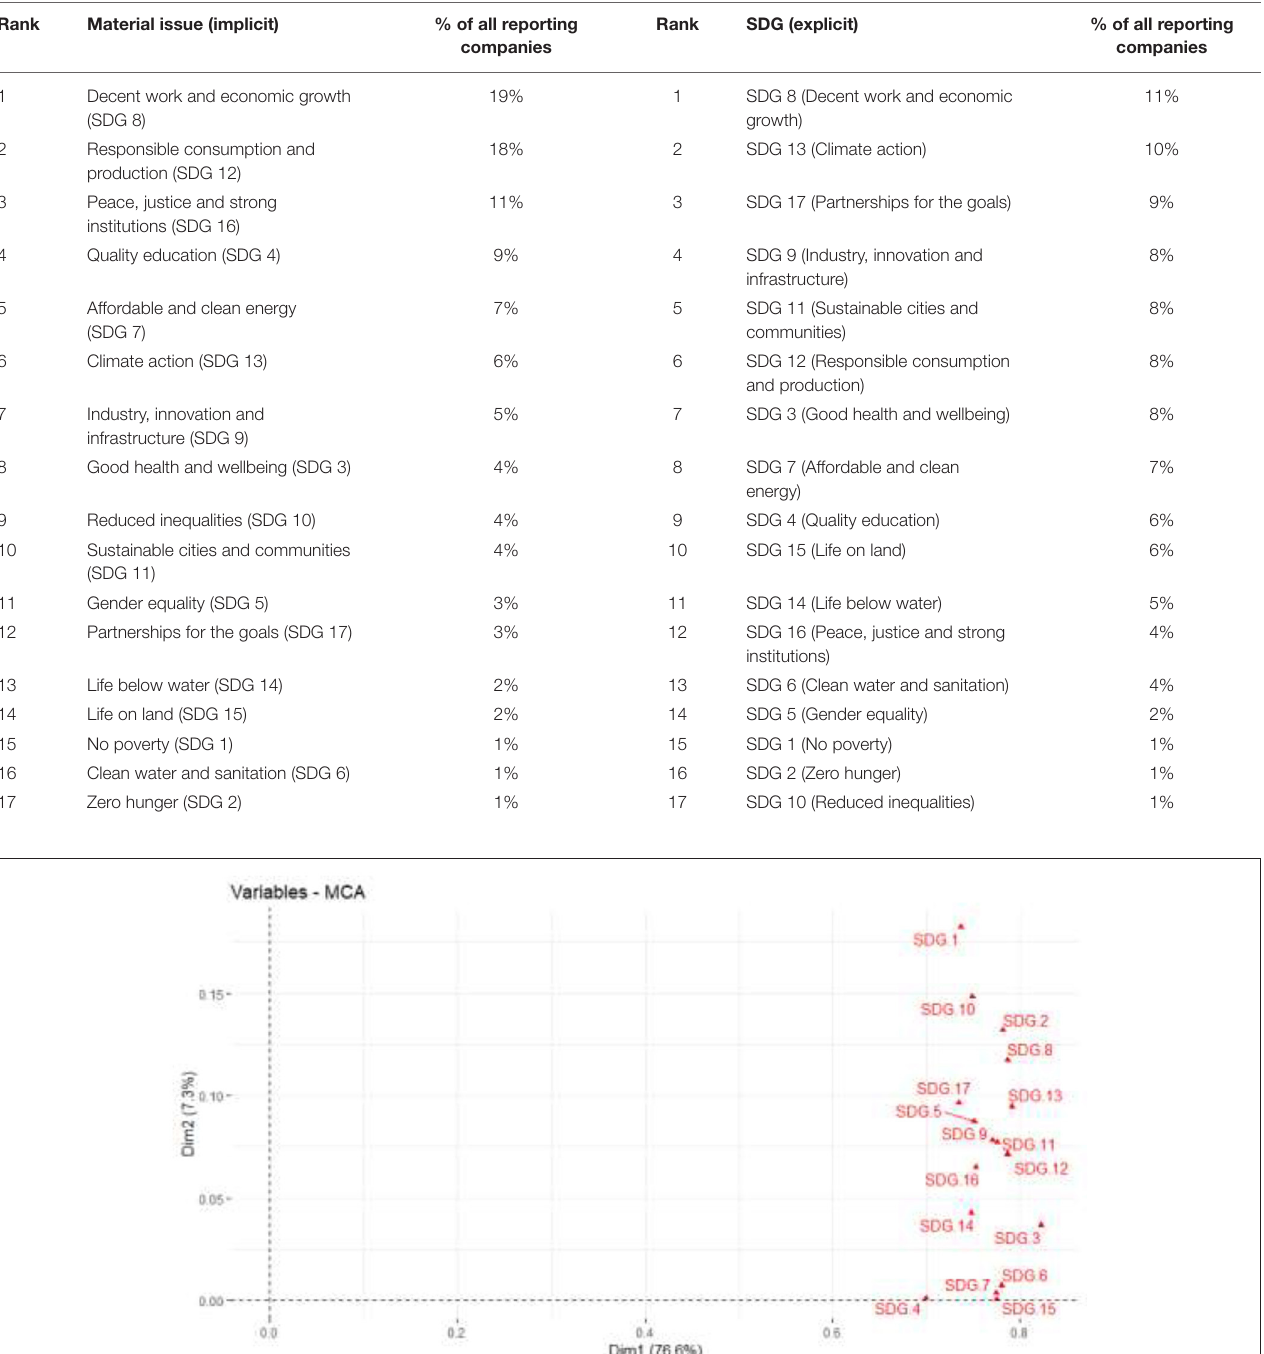
TABLE 1 | Ranking implicit and explicit SDG reporting of all reporting companies (little, average, high, and very high reporting). Rank